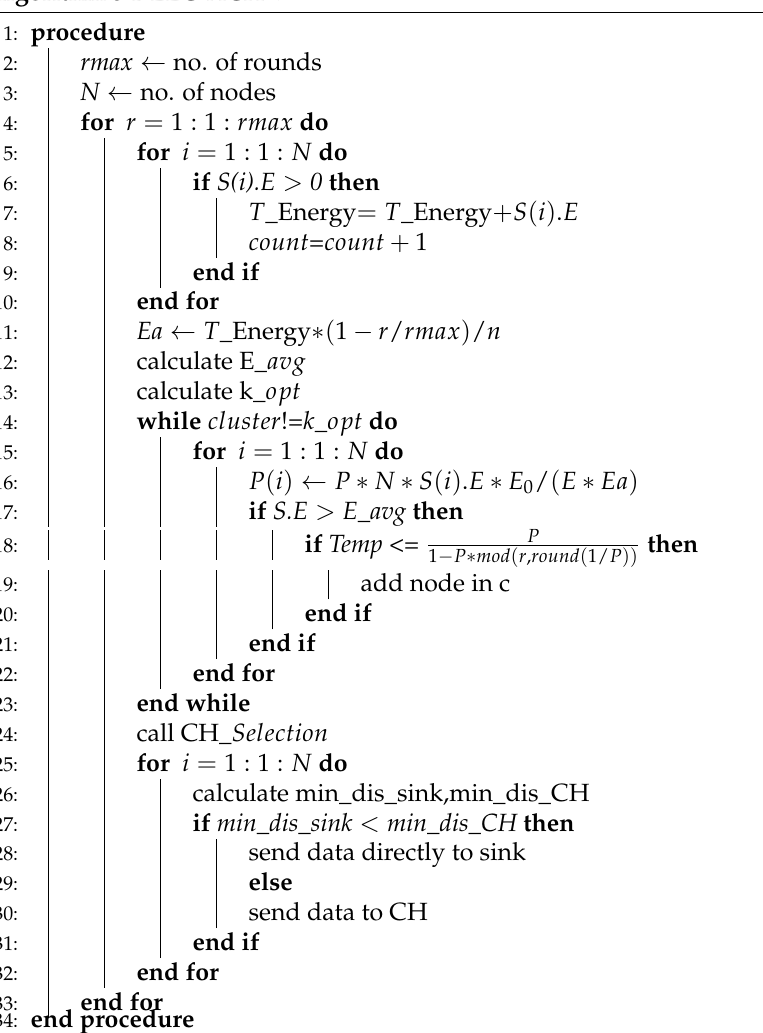
Algorithm 5 DEEC-ACH 2